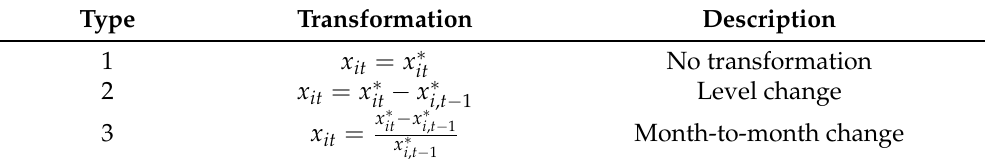
represents raw data, and x it represents the transformed it